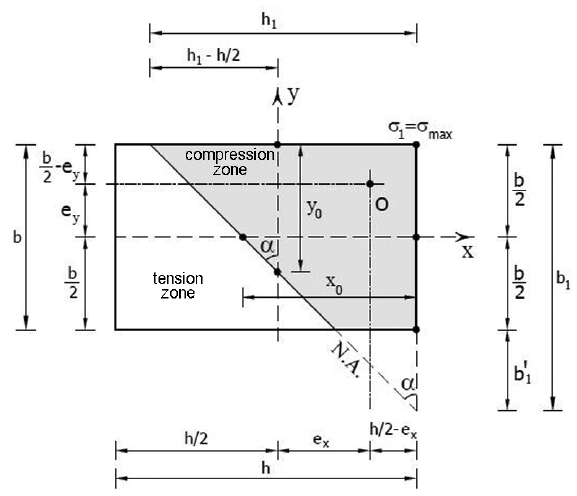
Fig. 7. Soil pressure distribution in rigid rectangular footing for the Case IV